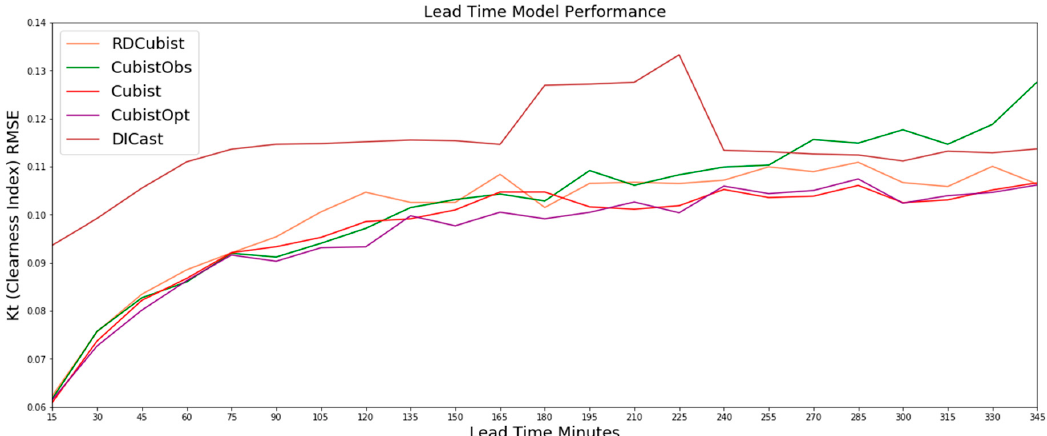
Figure A2. The RMSE results on the test dataset for the Cubist-based methods and the DICast ® forecasts, which show that the CubistOpt (green line) method generally performs the best of the three methods while the RD-Cubist (blue line) generally performs the worst of the three methods.